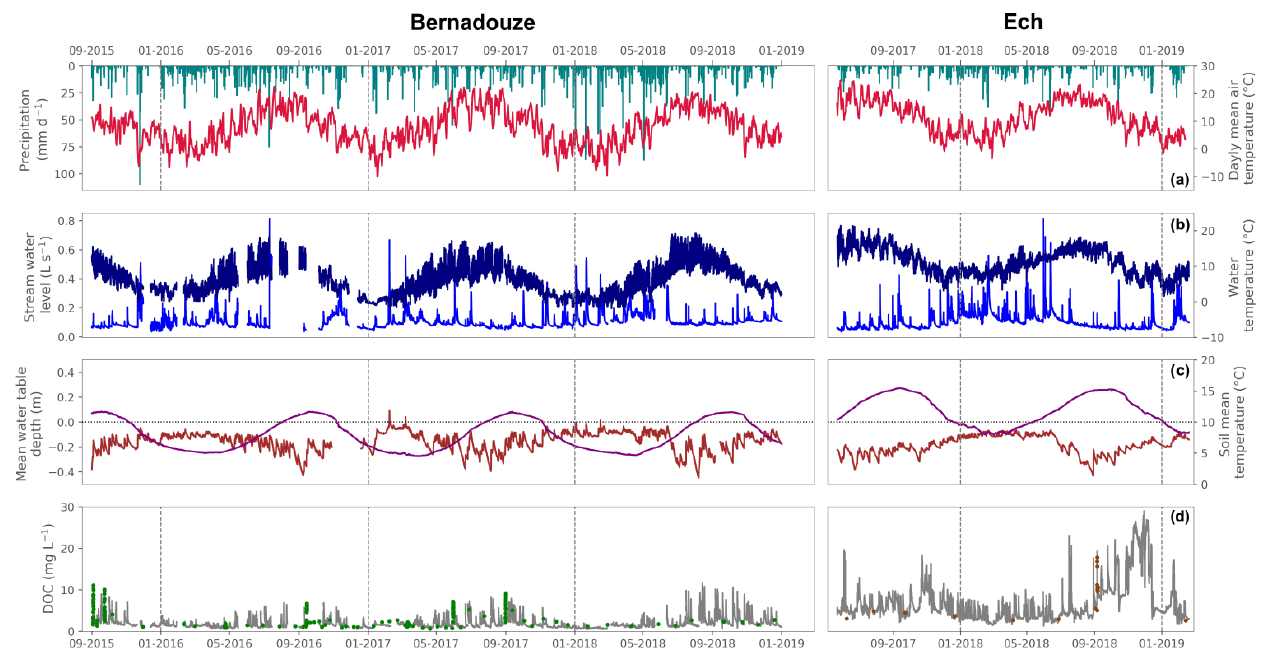
Figure 3. Precipitation and air temperature (a) , stream temperature and water level (b) , high-frequency DOC concentration (c) , and mean water table depth variation and peat water temperature (d) . Time series observed at the outlet of the Bernadouze fen (left panels) from 1 September 2015 to 31 December 2018 and at the outlet of the Ech bog (right panels) from 22 May 2015 to 13 February 2019. The vertical gray lines represent a change of year. Green (for Bernadouze) and brown (for Ech) plots in time series (c) refer to DOC concentration measured in water grab samples and automated flood